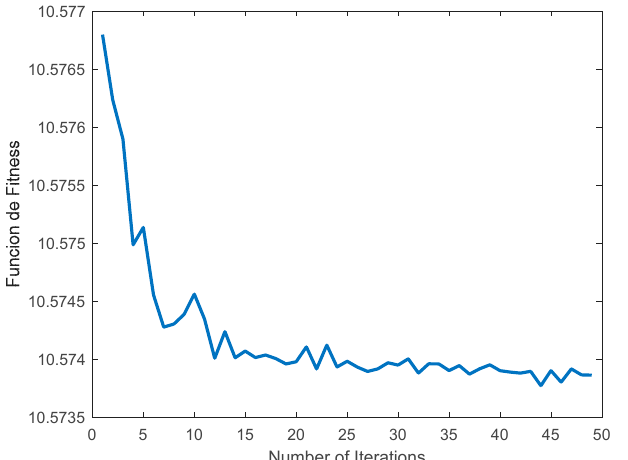
Figure 9. Evolution of the objective function J norm as the number of iterations increases using PSO for the IO-DMRAC. The optimal parameter values obtained for the case of IO-DMRAC were: 𝛾 = 5.3633 , 𝛾 = 0.1 , 𝛾 = 0.1 , 𝛾 = 49.58 , (cid:3038) (cid:2869)(cid:2869) (cid:2869)(cid:2870) (cid:2869)(cid:2871) 𝛾 = 0.1 , 𝛾 = 0.1 , 𝛾 = 7.6837 and 𝛾 = 0.1 . (cid:2868) (cid:2870)(cid:2869) (cid:2870)(cid:2870) (cid:2870)(cid:2871)